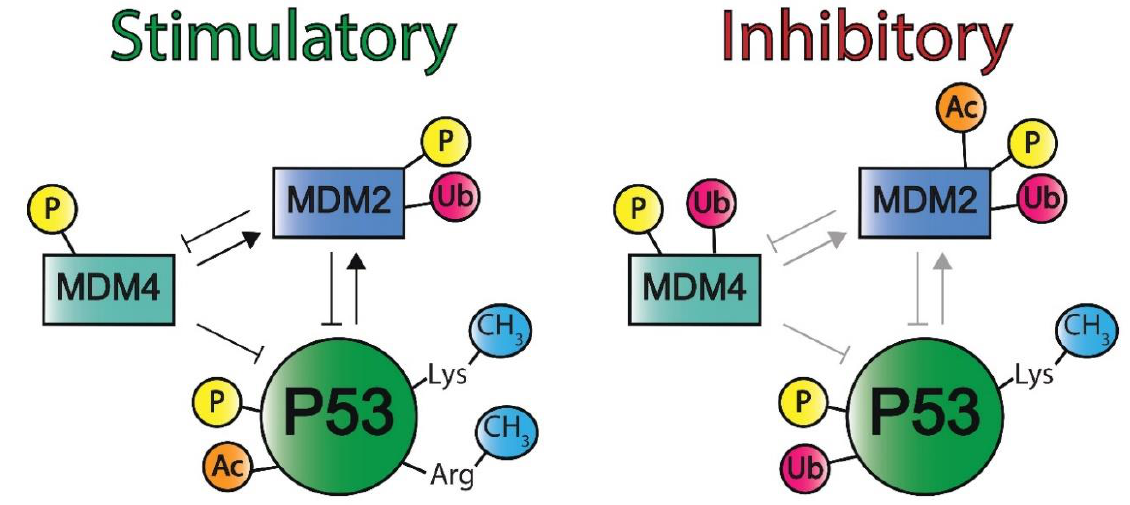
Figure 6. The different post-translational modifications of P53 and Mouse Double Minute 2 and 4. P53 can be activated (left) through phosphorylation (P), acetylation (Ac), and methylation (CH3) on lysine and arginine residues. Mouse Double Minute 2 (MDM2) can be phosphorylated and ubiquitinated (Ub) and Mouse Double Minute 4 (MDM4) can be phosphorylated. Post-translational modifications (PTMs) can also inhibit these proteins, which also decreases the regulation of each other (right). Phosphorylation, ubiquitination, and lysine methylation inactivate P53. Phosphorylation, acetylation, and ubiquitination inhibit MDM2, and phosphorylation and ubiquitination obstruct MDM4 activity. Of note, human genes and proteins are annotated in all capital letters (e.g., MDM2 and MDM2, respectively), whereas the murine homologs are annotated with a single capital letter (e.g., Mdm2 and Mdm2, respectively).